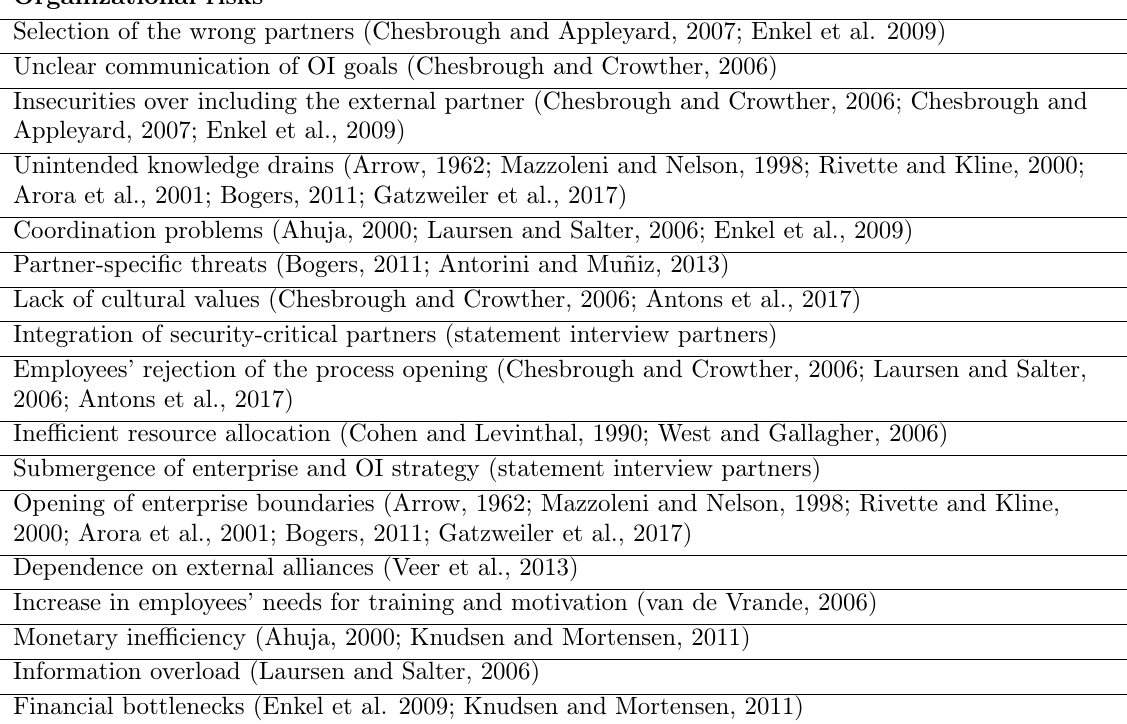
Table 2. Organizational risks of open innovation.